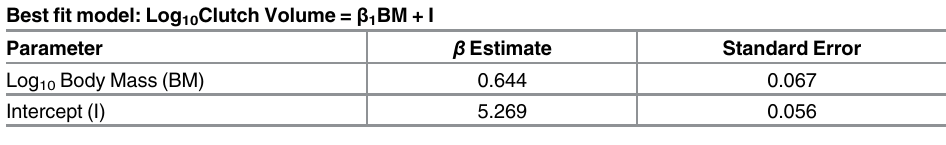
Table 6. Summary of parameter estimates for the best GEE reproductive ecology model fit only to